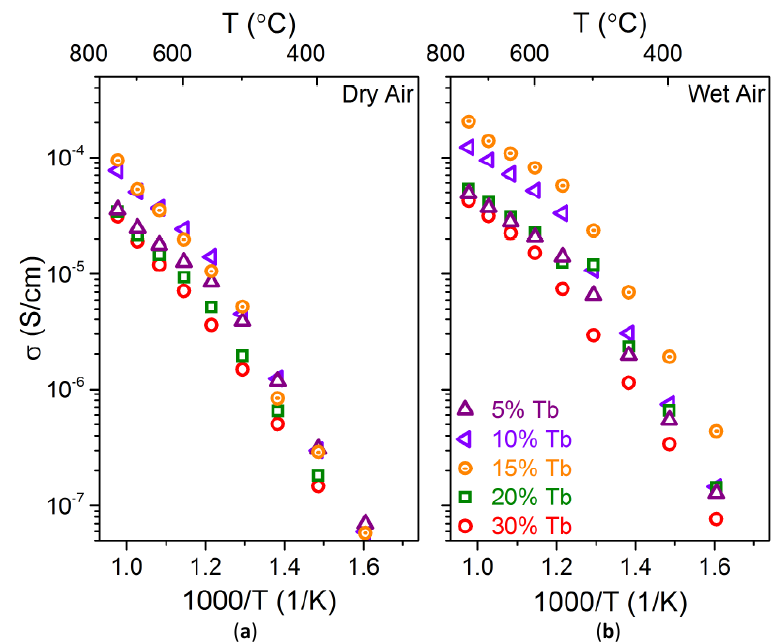
Figure 6. Nyquist plot of La 0.9 Tb 0.1 NbO 4+ δ measured in wet air at 500 ◦ C.